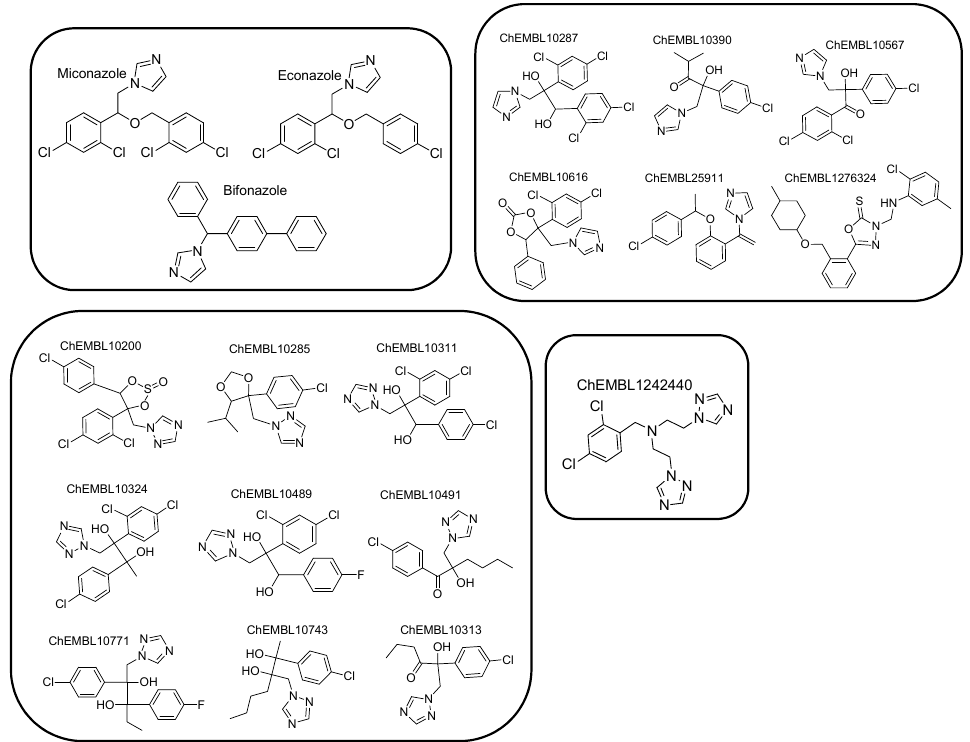
Figure 3. Chemical structures comprising the test set.